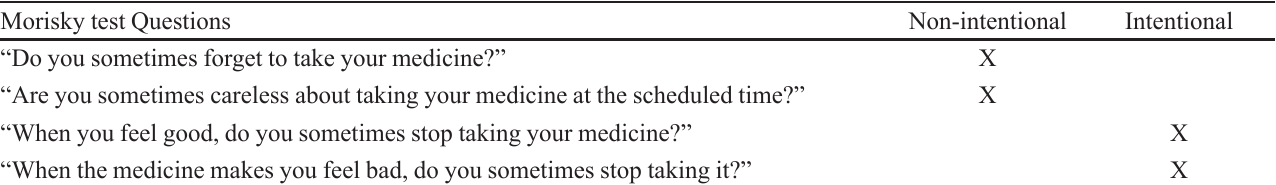
TABLE I - Questions on the Morisky test and the adherence level classification indicated by positive answers to the questions Morisky test